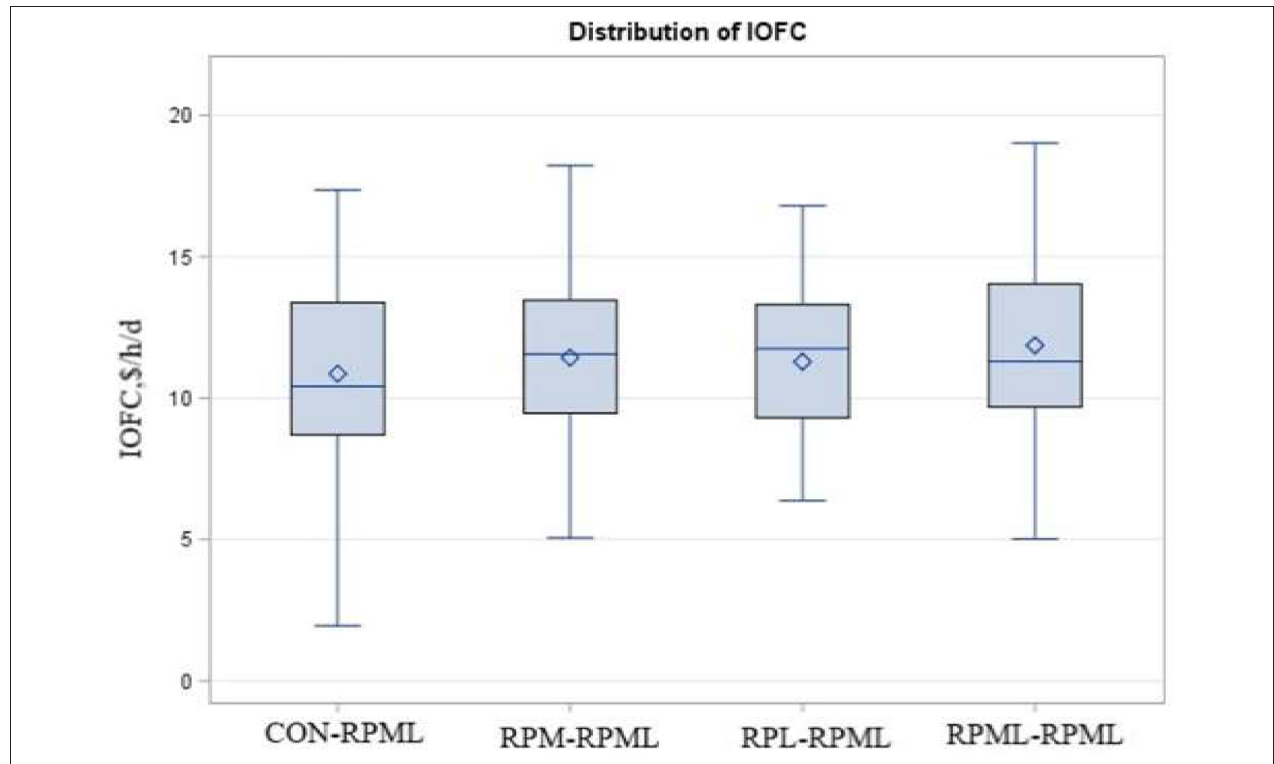
FIGURE 9 | Effect of supply ruminally protected Met and Lys to transition and milking dairy cows on income over feed cost (IOFC). Values are means; standard errors are represented by vertical bars.